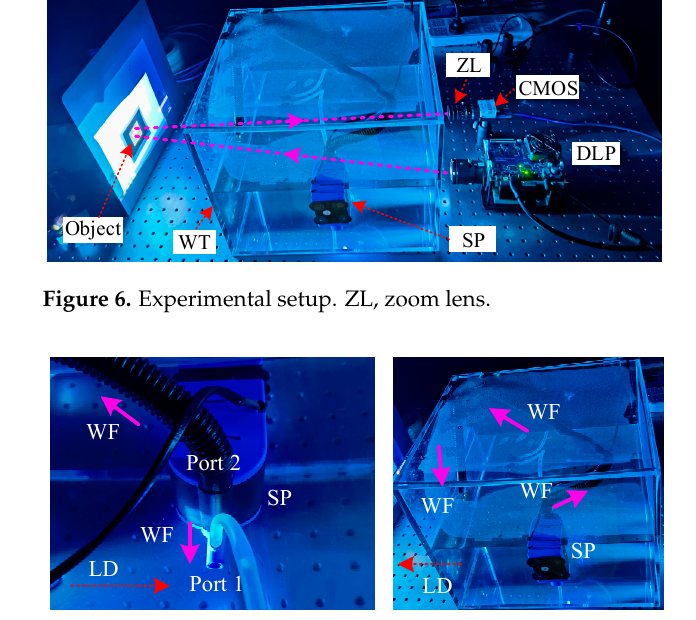
Figure 9. Experimental results of fourteen GI methods in the general environment (without WT).